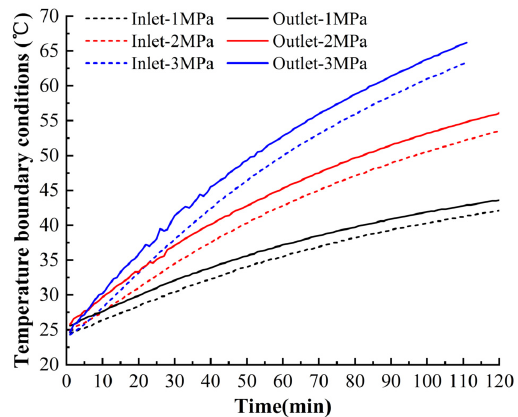
Figure 13. Inlet and outlet temperatures of the valve orifice obtained via measurement.